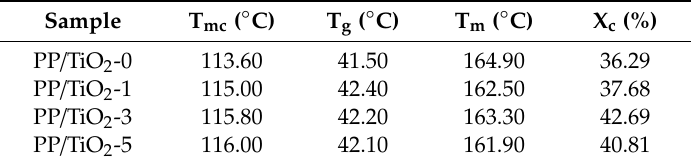
Table 2. Di ff erential scanning calorimetry (DSC) results of melt-blown